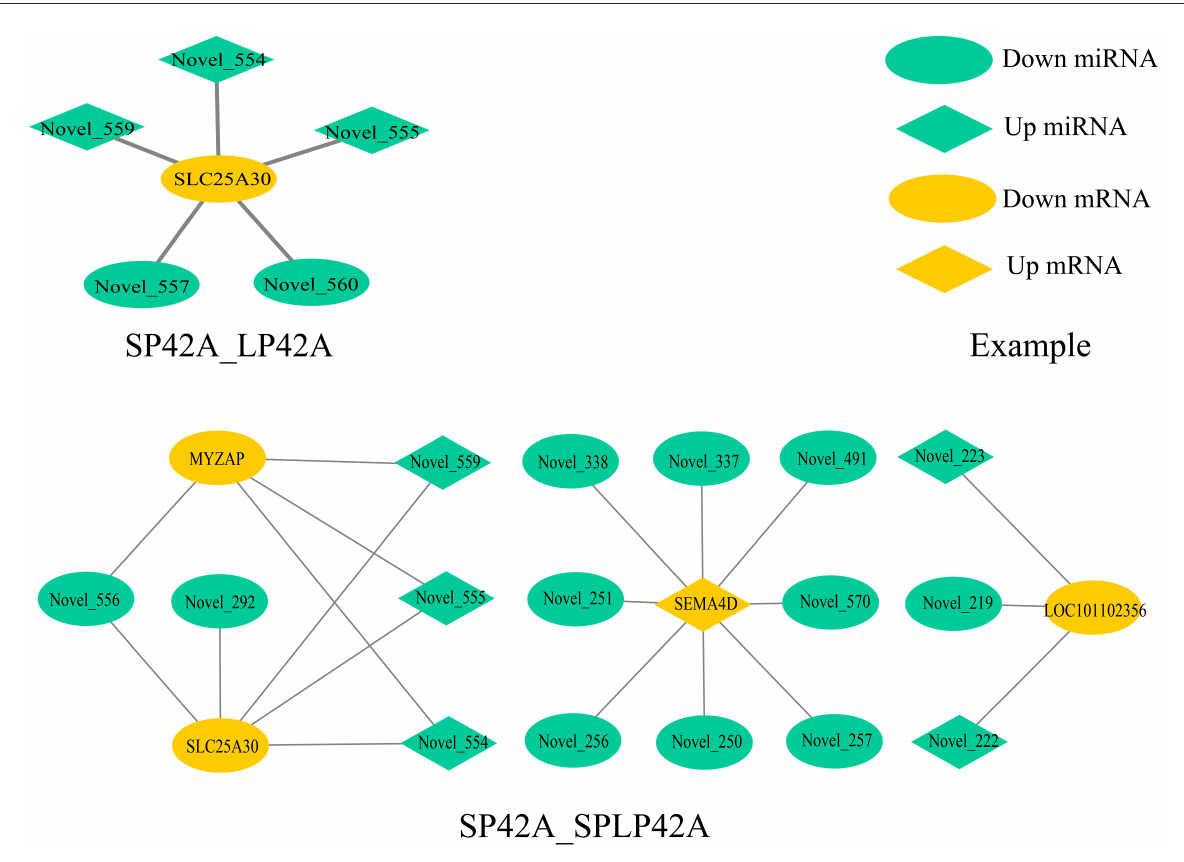
FIGURE6 Overview of mRNA–miRNA networks. Different colors represent DEM (green) and DEG (yellow), and different shapes represent different modes of regulation.